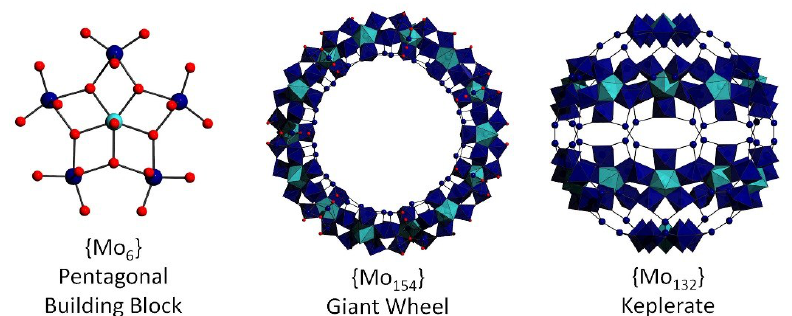
Figure 4. Ball-and-stick representation of the {Mo 6 } pentagonal bipyramidal building block integral to Molybdenum Blue and Brown architectures beside polyhedral and ball-and-stick representations of how the pentagonal units are arranged within the {Mo 154 } wheel and {Mo 132 } Keplerate. (Colour scheme: Mo, blue; O, red; the central Mo of the pentagonal units has been highlighted in pale blue). Interestingly, POM-based structures such as Keggin, Dawson, Anderson, etc., can be used as secondary building blocks for the construction of larger architectures. There are many methods that can be used for the modification and functionalization of POM clusters, including the choice of counterions, organic ligands and transition metals. The counterions are necessary for the existence of POMs as they stabilize the negative charge, but they can also influence the self-assembly process during the formation of POM structures. Depending on their size, charge, solubility etc., can stabilize the intermediate building blocks and “transitional” species in solution, which ultimately influence the structural features of the final product [24]. The organic ligands and first row transition metals can be used as ligands and metal linkers. Additionally, the exchange of redox “innocent” templates (e.g., SO 42− and PO 43− ) with redox active ones (e.g., SO 32− , SeO 32− ) is an alternative way to direct the